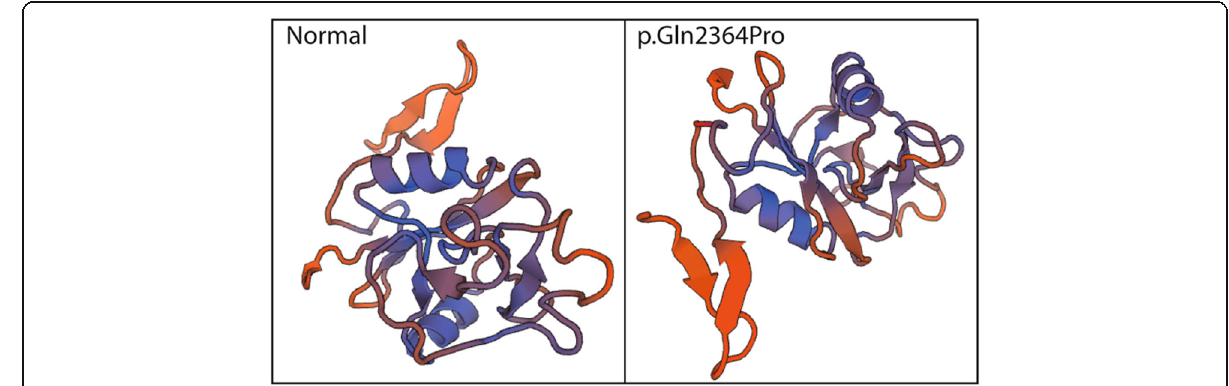
Fig. 2 The three-dimensional models for aggrecan protein with and without the